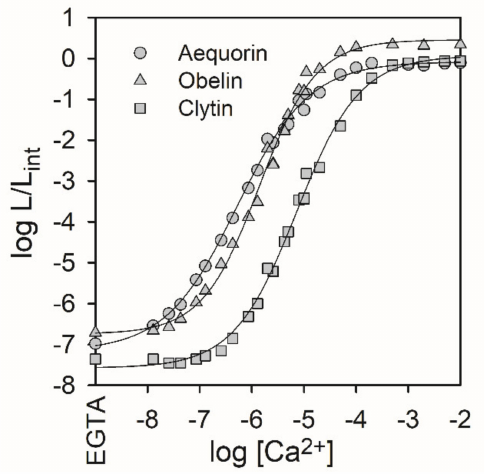
Figure 3. Ca2 + concentration—e ff ect curves for recombinant photoproteins. L—light intensity at the particular Ca2 + concentration; Lint—total light intensity at saturating Ca2 +